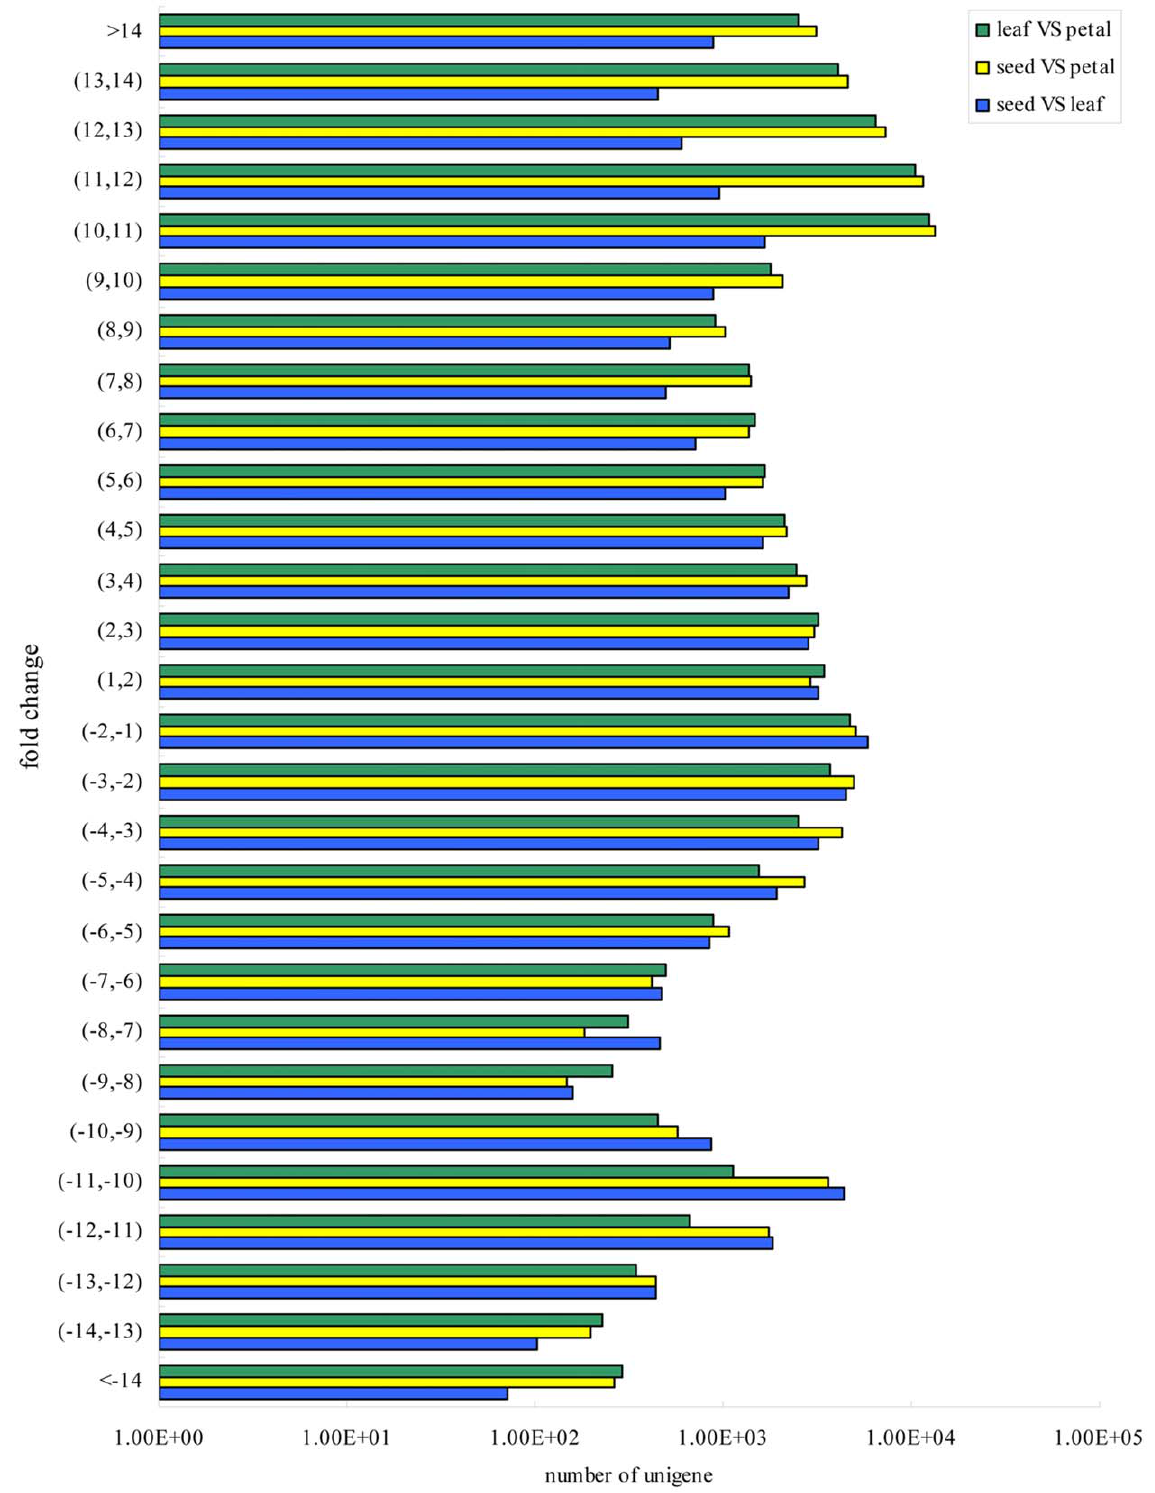
Figure 5. Unigenes that were differentially expressed in the seed, leaf and petal libraries.